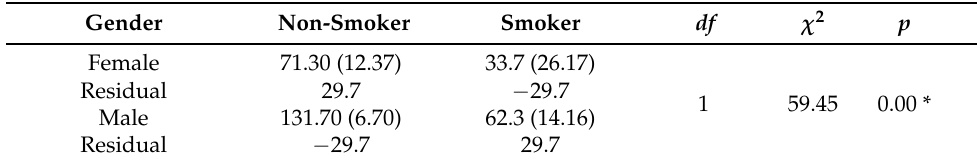
Table 10. Expected value of Gender vs. Smoking Status ( χ 2